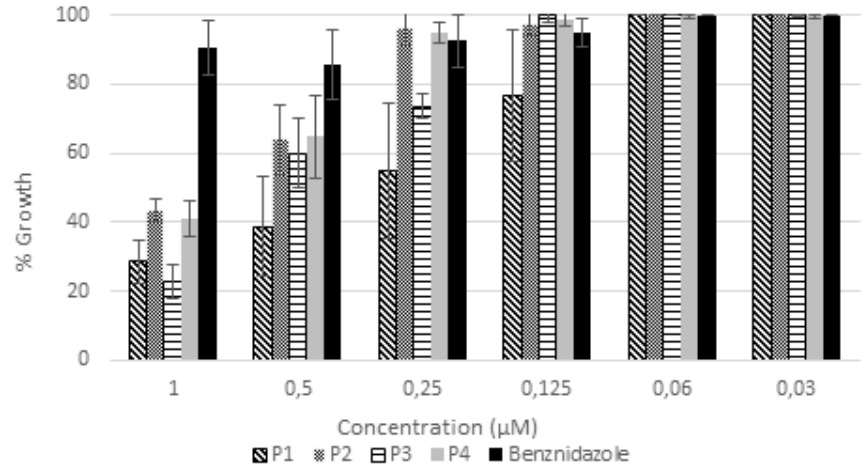
Figure 2. Biological activity of benznidazole and prodigiosin preparations against T. cruzi epimastigotes of the CL-B5 strain expressed as percentage of growth with corresponding standard